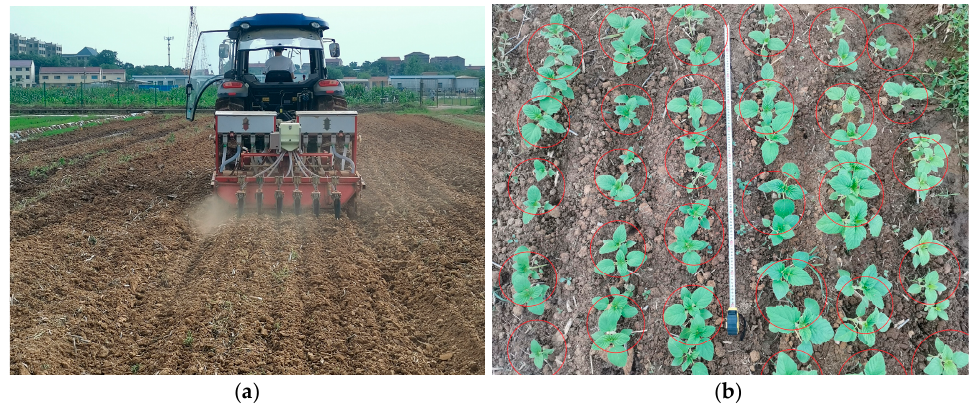
Figure 15. ( a ) Seeding process of field experiment; ( b ) seedling growth of